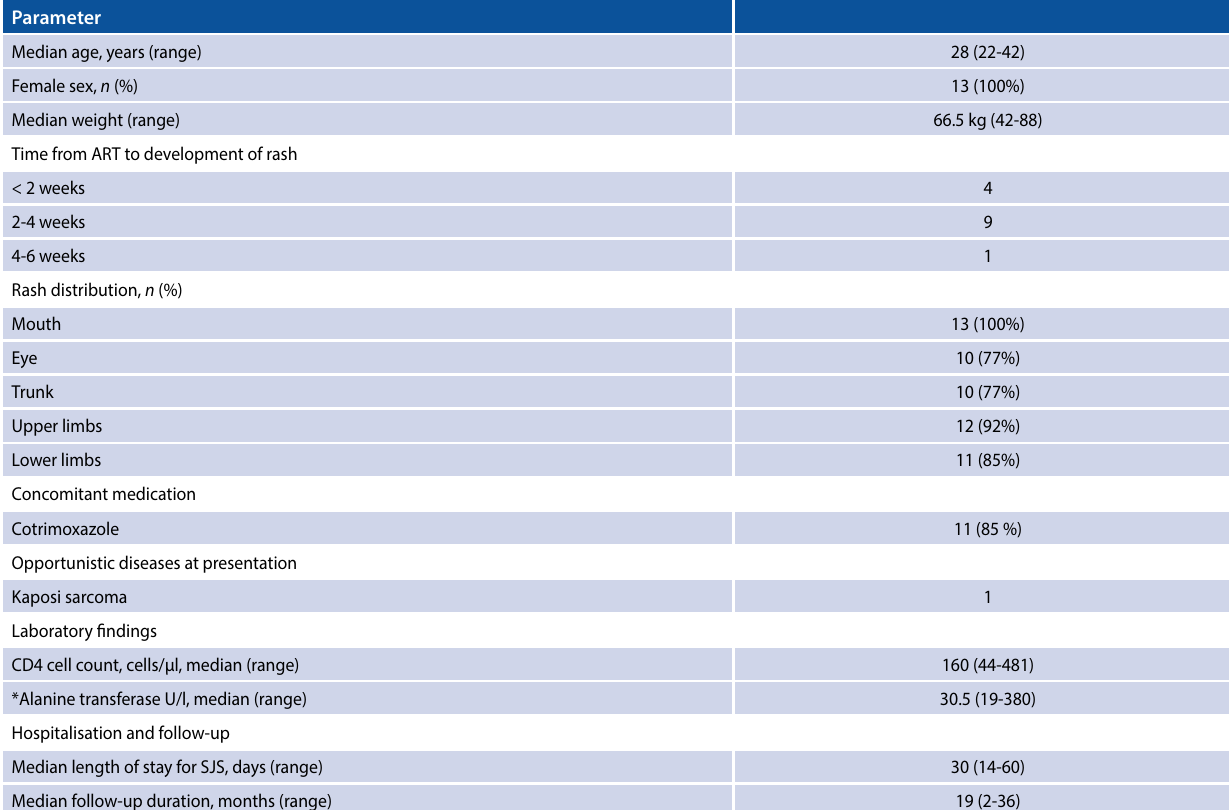
*Alanine transferase normal range: